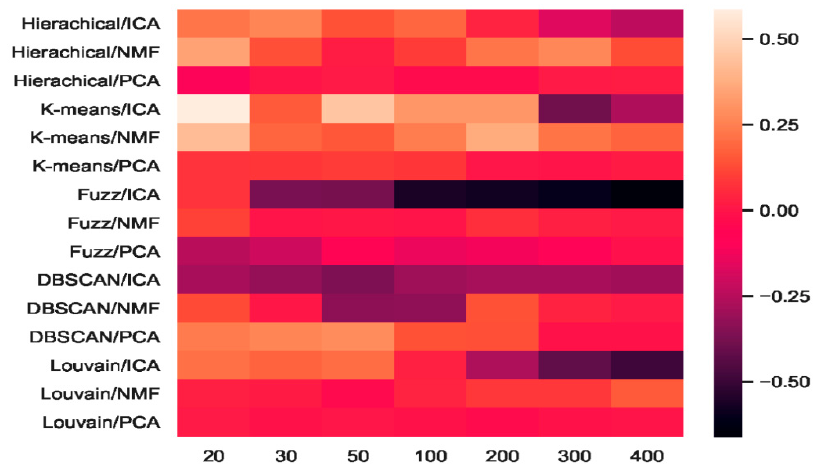
Figure 6. Heatmap of clustering accuracy improvement using feature extraction on the mouse cortex with 500 genes.